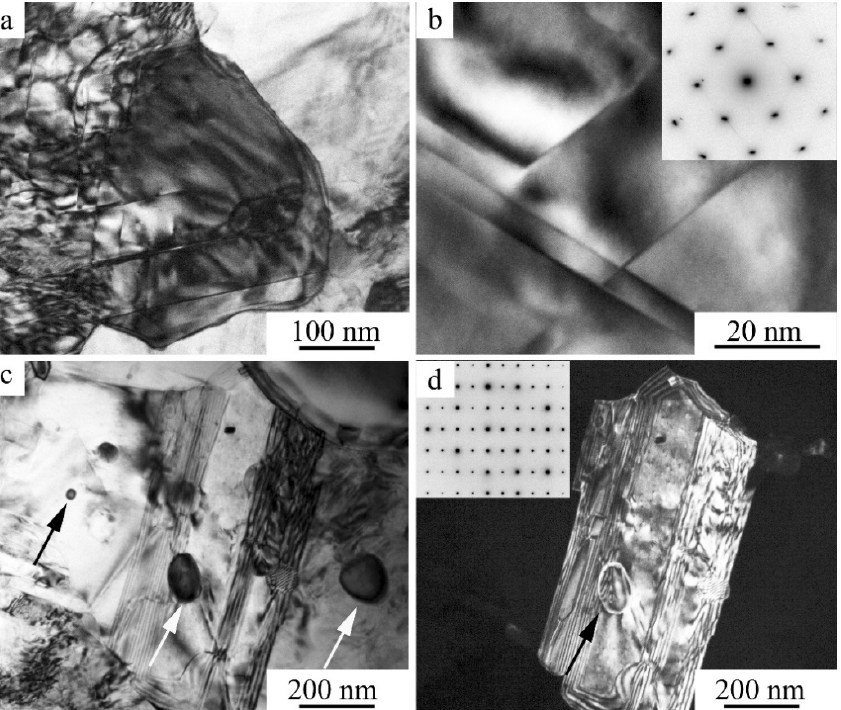
Figure 10. ( a , c ) Bright- and ( b , d ) dark-field TEM images (amplitude contrast) of the microstructure of the ( a , b ) α , ( c , d ) γ 2 , and B 2 ′ phases after compression tests at 773 K ( v = 1 mm/min). According to temperature measurements of electrical resistance ρ ( T ), it was found that the critical TMT temperatures of MPC alloys increased compared to the tempera- tures of the quenched alloy (Figure 11, Table 2). These temperatures became noticeably higher than room temperature due to some depletion of the alloy matrix by aluminum caused by the partial decomposition that occurred. Figure 11. Temperature dependences ρ ( T ) of the Cu-14Al-4Ni alloy after ( a ) quenching, ( b ) MPC at 973 K, and ( c ) MPC at 773 K. The arrows show the heating and cooling during the experiment. Table 2. Critical temperatures of the start ( M s , A s ) and finish ( M f , A f ) of the forward and reverse TMTs in the Cu-14Al-4Ni alloy after various treatments. Treatment